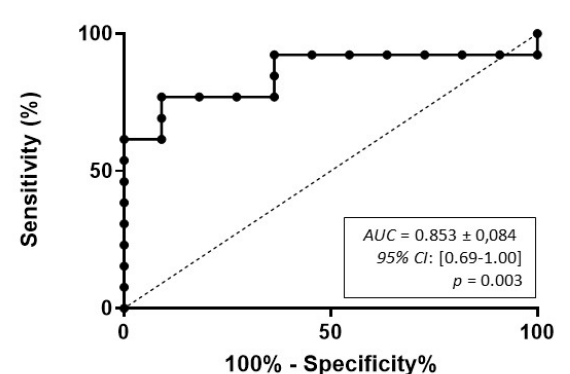
Figure 3. Receiver operating characteristic (ROC) curve analysis for miR-483-5p absolute copy number in ACC patients. Three months-post-operative serum samples can discriminate between NR3yrs and R < 3yrs patients with significant accuracy. The area under the curve (AUC), the 95% confidence interval (CI) and the p value are indicated.